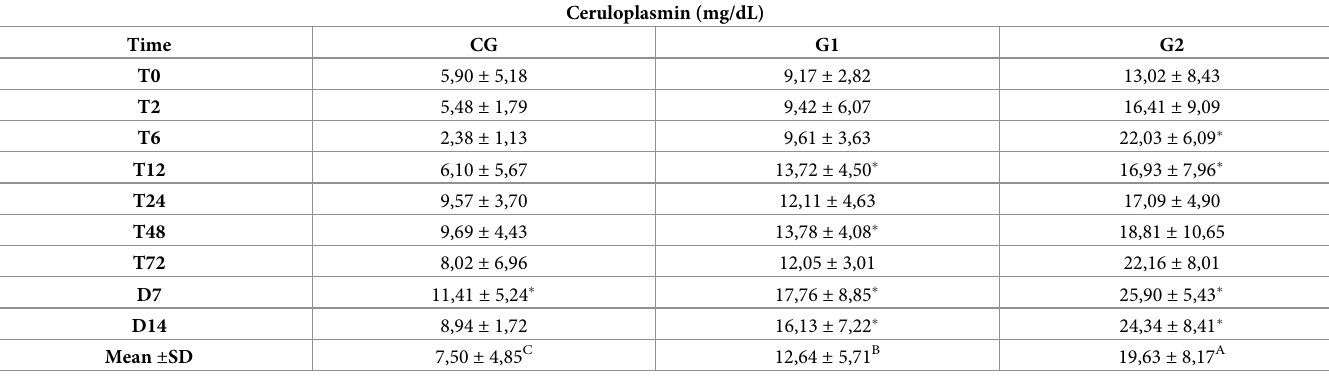
( � ) represent differences compared to baseline time (T0) within the group; Different capital letters represent differences between groups at the same time; p �